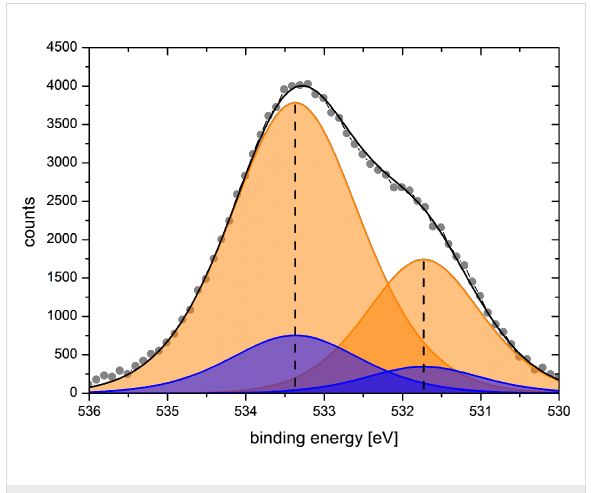
Figure 3: O 1s contributions of polycarbonate to the XP spectra of uncoated (orange, grey dots are measured counts) and SiO 2 -coated (blue, 28 cycles) membranes. For details see